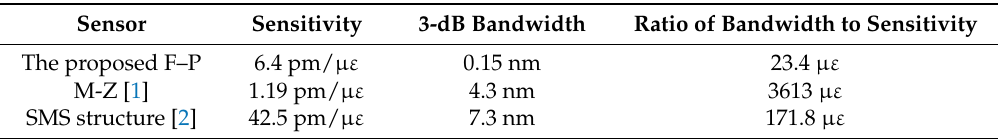
Table 1. Comparisons between the references based on their interferometer-type sensors and the proposed sensor.